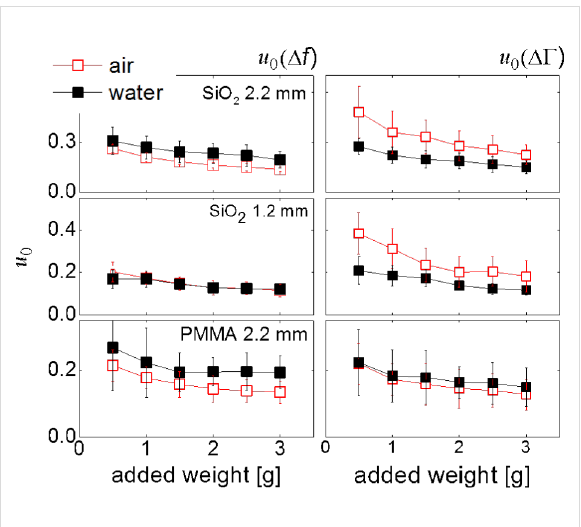
Figure 8: Friction coefficients, µ, obtained by analyzing the slopes in plots of Δ f versus u 0 (left) and ΔΓ versus u 0 (right), following Equation 12. The two ways to derive µ should lead to the same values, ideally. Further, µ should be of the order of unity. The decrease of µ with increasing normal force can be explained with an increased con- tact area and a concomitant increase in the stress concentration at the edge of the